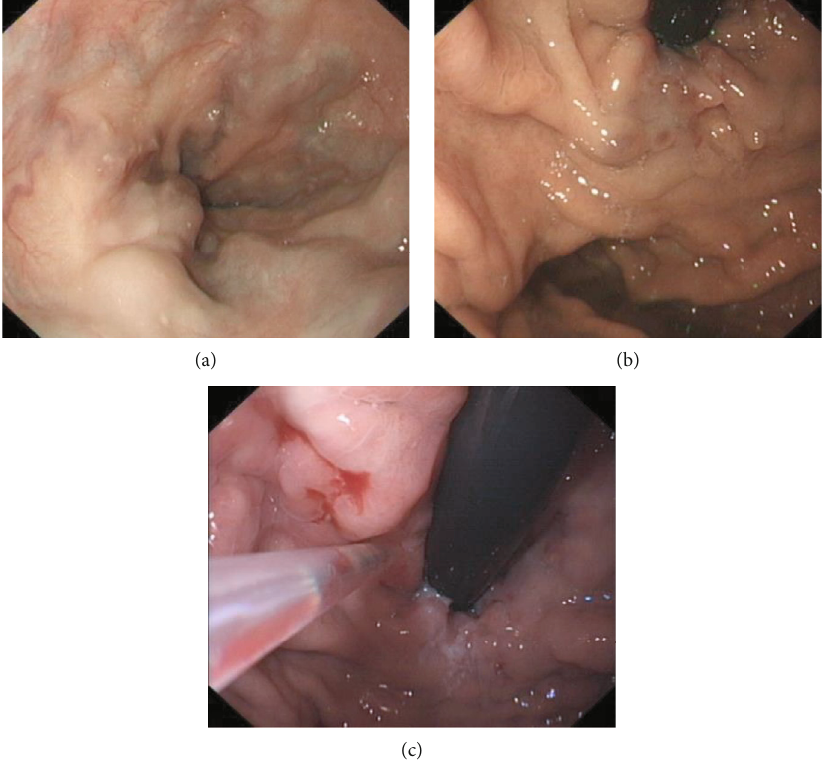
Figure 1: Endoscopic fi nding of (a) esophageal varices, (b) gastric varices, and (c) intravascular injection of cyanoacrylate of neovascularisation of gastric